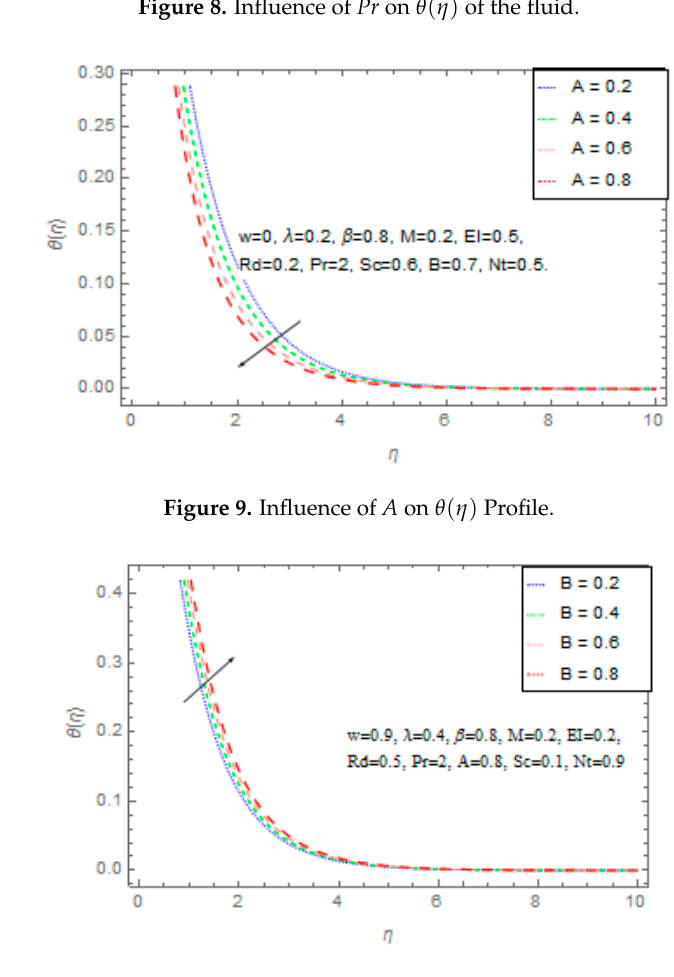
Figure 8. Influence of Pr on θ ( η ) of the fluid.